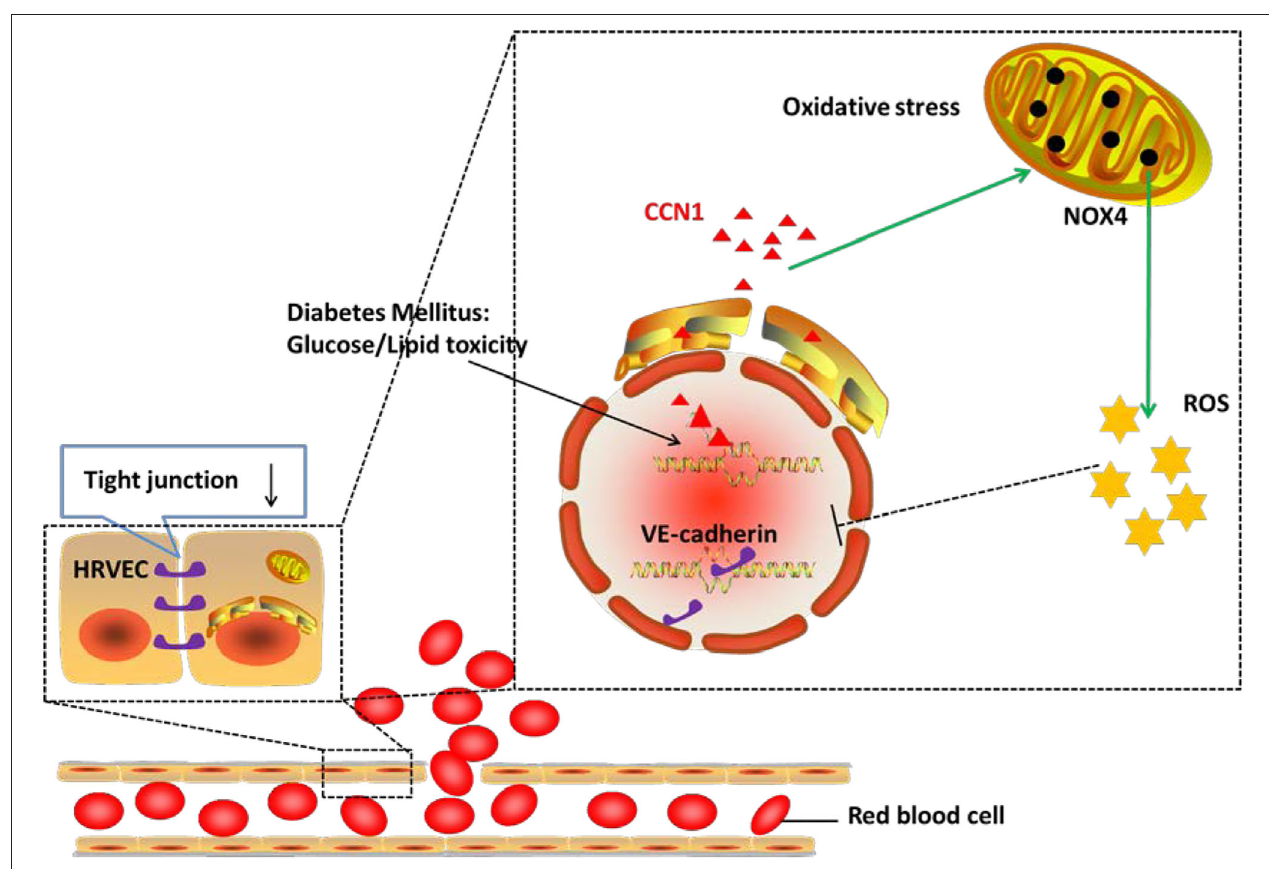
FIGURE 7 | Mechanism of action of CCN1 in the pathogenesis of diabetic retinopathy (DR). The abnormal increase in CCN1 results from either the lipotoxicity or glucotoxicity of diabetes mellitus and leads to upregulated NOX4/ROS production, which further inhibits the expression of the tight junction